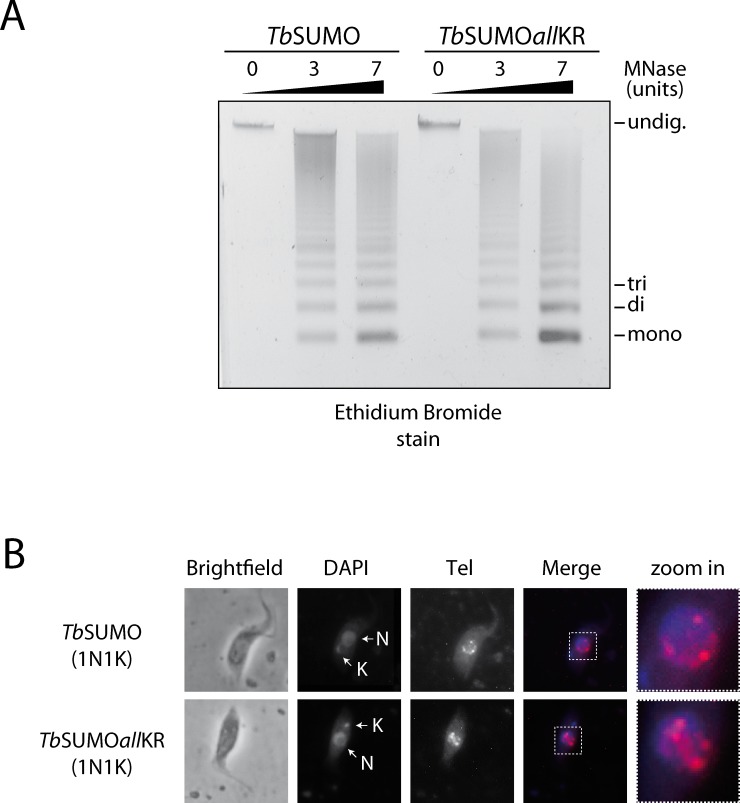
Chromatin organization in TbSUMOallKR mutants.(A) Genomic DNA isolated from HisHA-TbSUMO (TbSUMO) or HisHA-TbSUMOallKR (TbSUMOallKR) strains was digested during 5 minutes with increasing units of MNase (0, 3 and 7 U). Samples were separated on 2% agarose gels and visualized under UV light after ethidium bromide staining. Degradation products corresponding to DNA that had been bound to mono-, di-, or tri-nucleosomes, as well as undigested DNA (undig.) are indicated.Bands were quantified with Image Studio software and statistical analysis was performed using Student's t test. (B) Fluorescent in situ hybridization was used for telomere labelling (Tel, red). Representative images are shown for HisHA-TbSUMO (TbSUMO) and HisHA-TbSUMOallKR (TbSUMOallKR) parasites. DNA was visualized using DAPI (blue). N, nucleus; K, kinetoplast DNA. Merged images are shown.